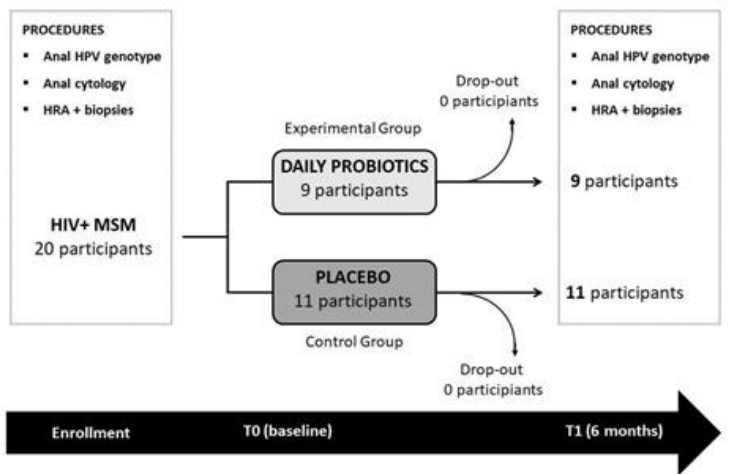
Figure 1. Study flow-chart. Primary outcomes were: (i) change from baseline in the number of HPV positive anal swabs, (ii) change from baseline in the number of dysplastic lesions. The rate of adverse events throughout the study was evaluated as secondary